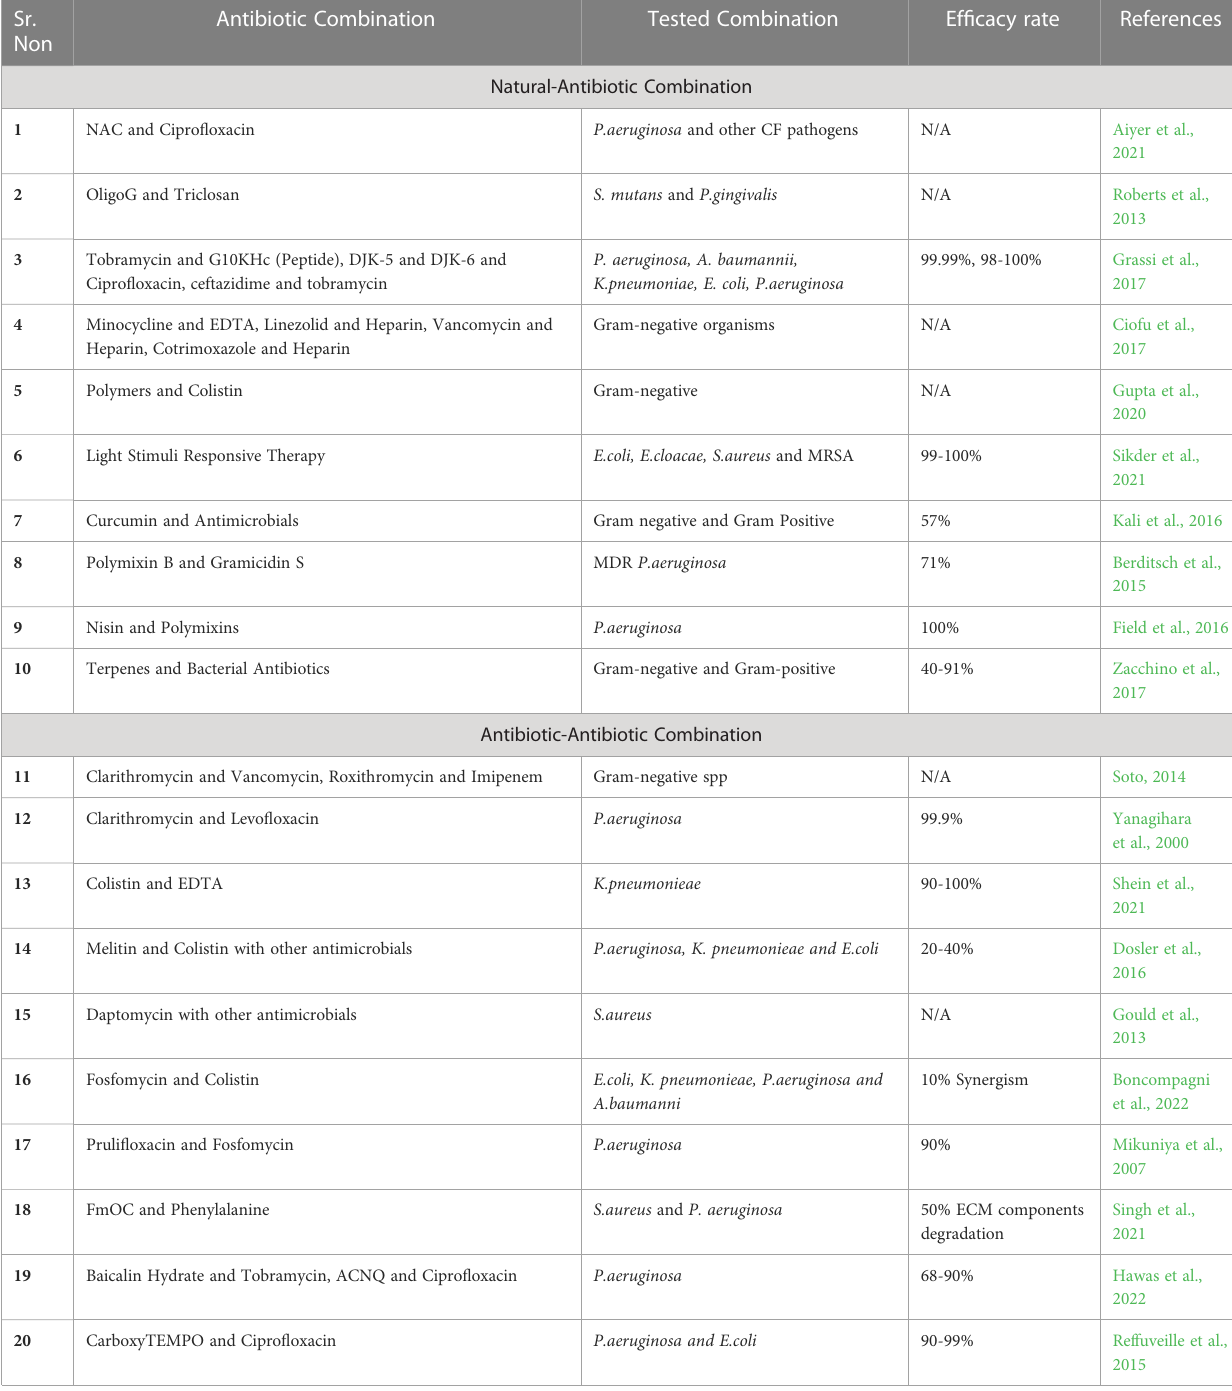
TABLE 1 Summarization of combination therapies against gram-negative and gram-positive organisms (N/A- Not Available). Sr.